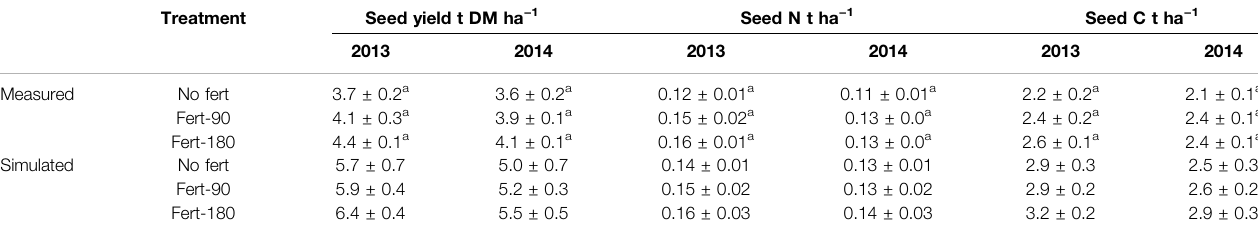
TABLE 2 | Oilseed rape seed yield and N and C removed by seeds at the experimental site Reinshof in 2013 and 2014 ( n (cid:2) 3) as in fl uenced by fertilizer treatments. Treatment